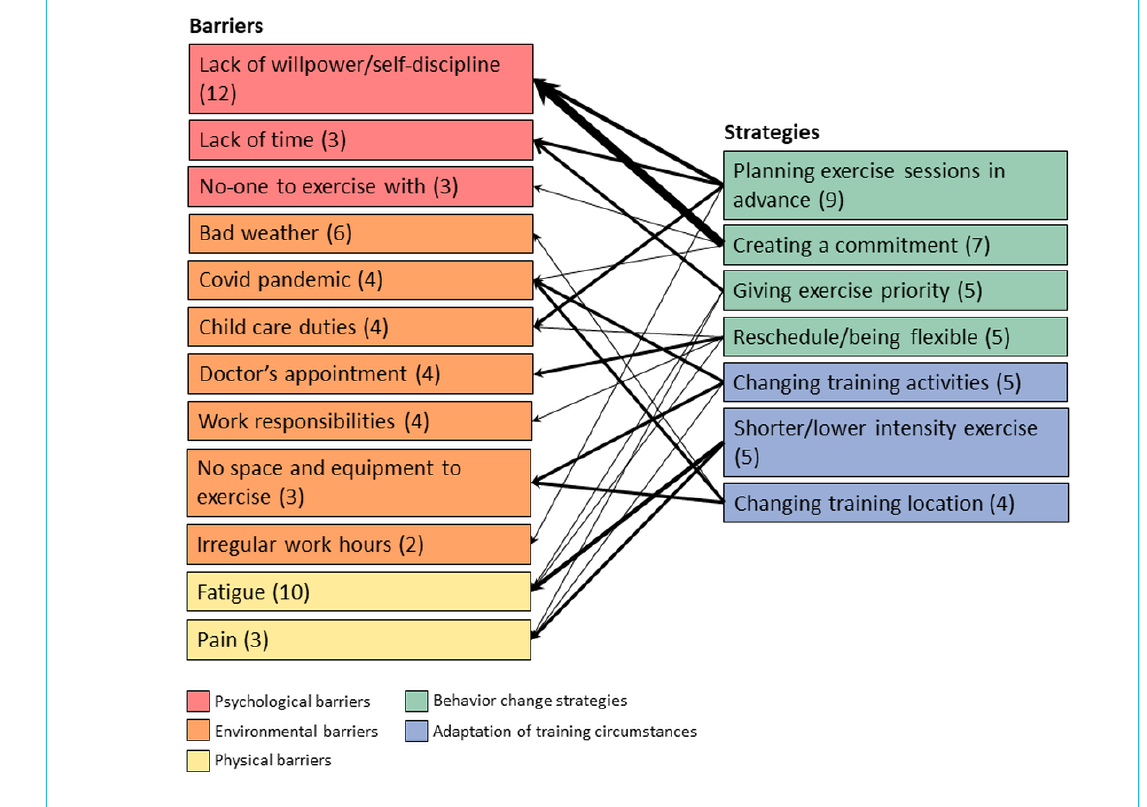
Figure 3: Frequently named strategies to overcome certain barriers, with number of patients reporting specific barriers and strategies indicat- ed in